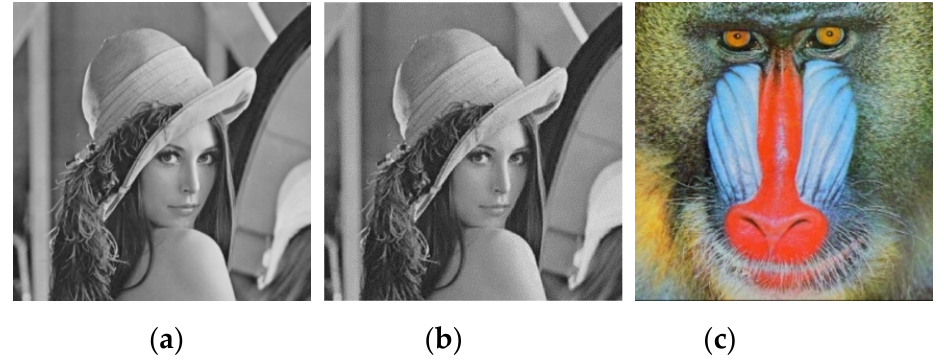
Plain images of size 512 × 512, including grayscale image Lena with pixel depth 8BPP, grayscale image Lena with pixel depth 16BPP, and color image Baboon with pixel depth